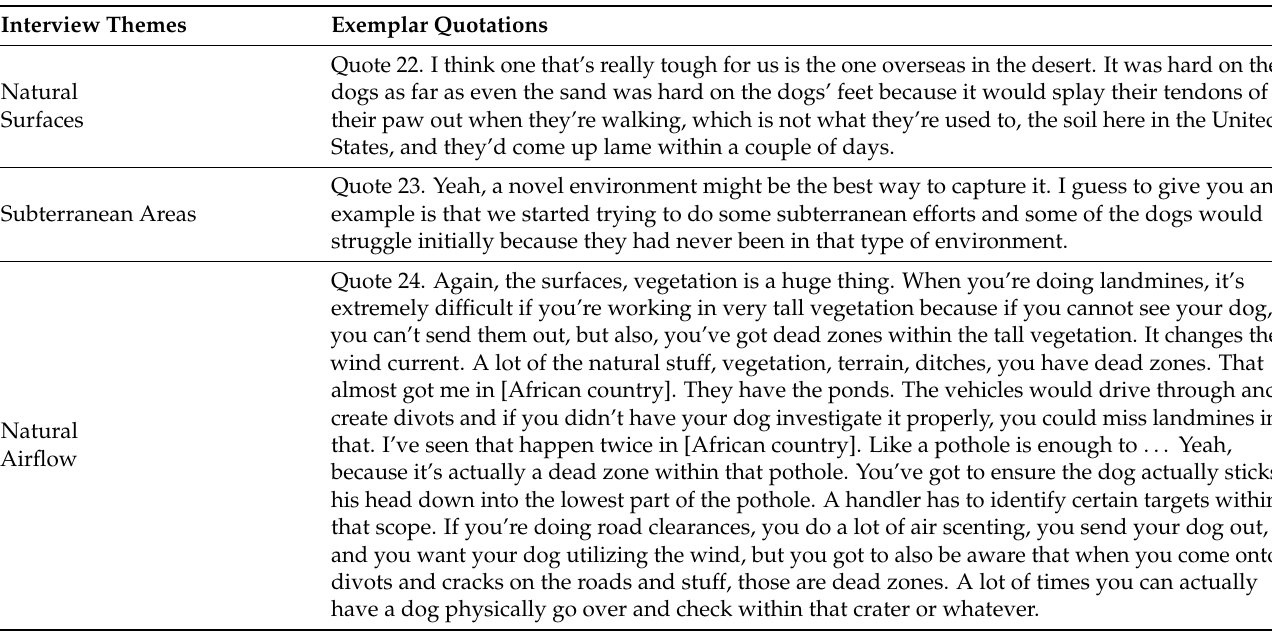
Table 5. Natural physical environmental factor themes and exemplar